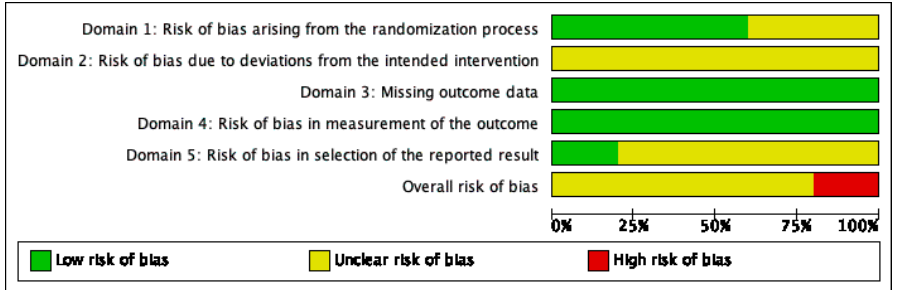
Figure 3. Authors’ judgements about each